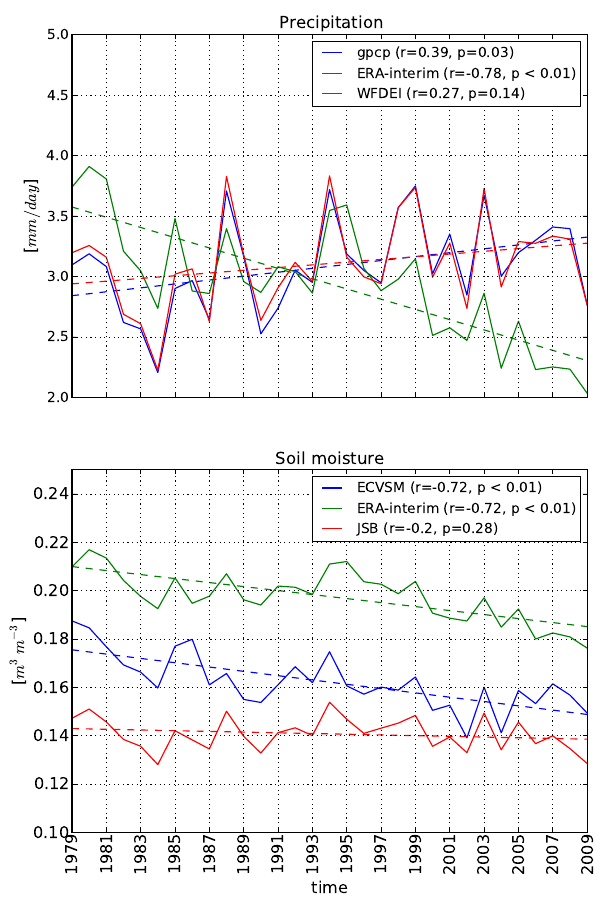
Fig. 9. Time series of mean Sahelian rainfall (top panel) and soil Fig. 9. Timeseries of mean Sahelian rainfall (top) and soil moisture (bottom) as aggregated over the area moisture (bottom panel) as aggregated over the area from 10 to from 10 ◦ N to 20 ◦ N and 20 ◦ W to 40 ◦ E for the different datasets used in the study. 20 ◦ N and 20 ◦ W to 40 ◦ E for the different datasets used in the study. 41